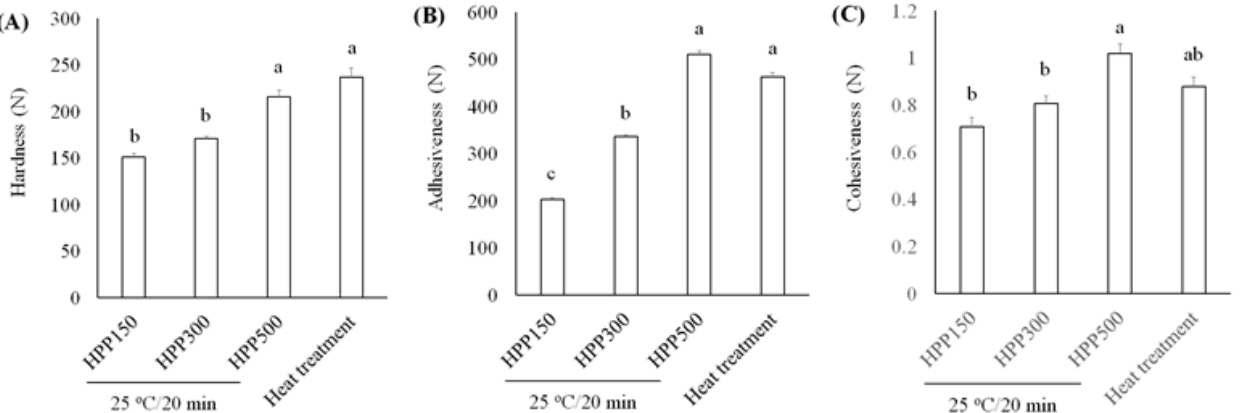
Figure 6. Investigating the textural parameters ( A ) hardness, ( B ) adhesiveness, and ( C ) cohesiveness of L. acidophilus BCRC14079-fermented mango jam by HPP and heat treatment. Data are shown as means ± SD ( n = 3). Significant difference was shown by various letters ( p < 0.05).